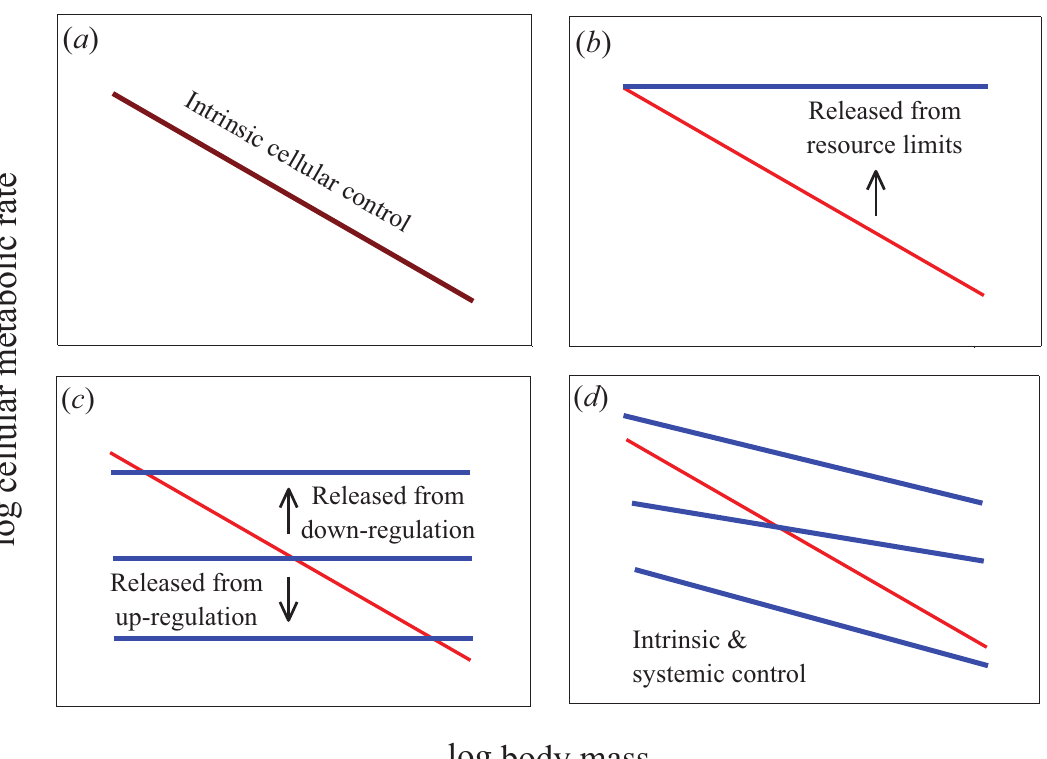
Figure 1. Hypothetical relationships for how log mass-specific cellular metabolic rates in vitro (for cultured cells in oxygen- and nutrient-rich media: blue lines) versus in vivo (for cells intact in whole organisms: red lines) should scale with log body mass. ( a ) If intrinsic cellular effects predominate, then the scaling of in vitro and in vivo rates should be the same or nearly so ( i.e. , the scaling lines should overlap, as shown by a purple line). ( b ) If